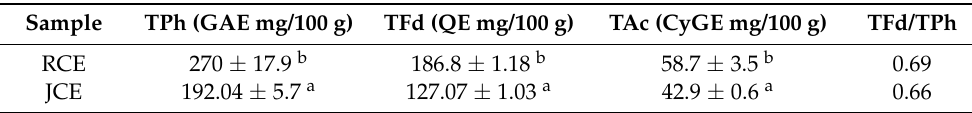
Table 1. Total phenolic, flavonoid and anthocyanin content of raspberry and raspberry juice crude extracts (mg/100 g